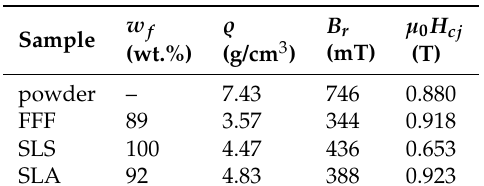
Table 1. Properties of the isotropic NdFeB powder (MQP-S-11-9 from Magnequench Corporation.) and the samples printed with the different AM methods. w f . . . filling mass fraction, (cid:36) . . . volumetric mass density, B r . . . residual Induction, and µ 0 H cj . . . intrinsic coercivity.